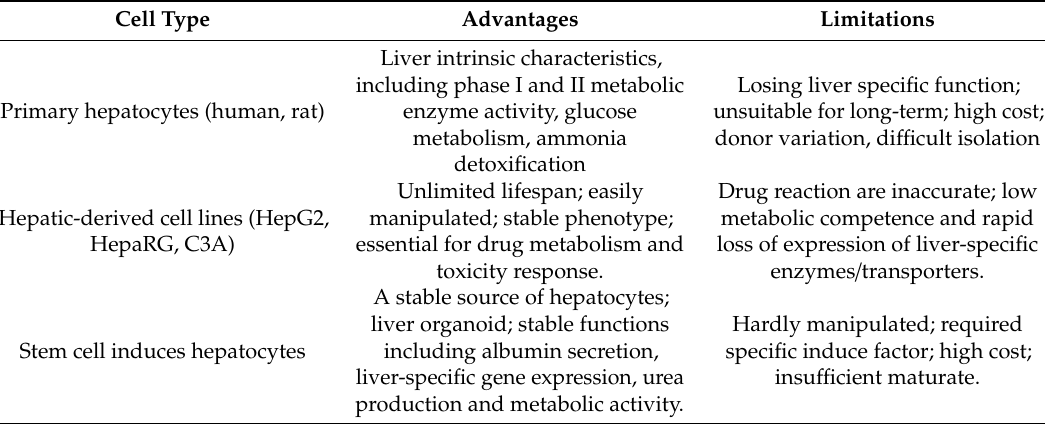
Table 3. Advantages and limitations of cells used in